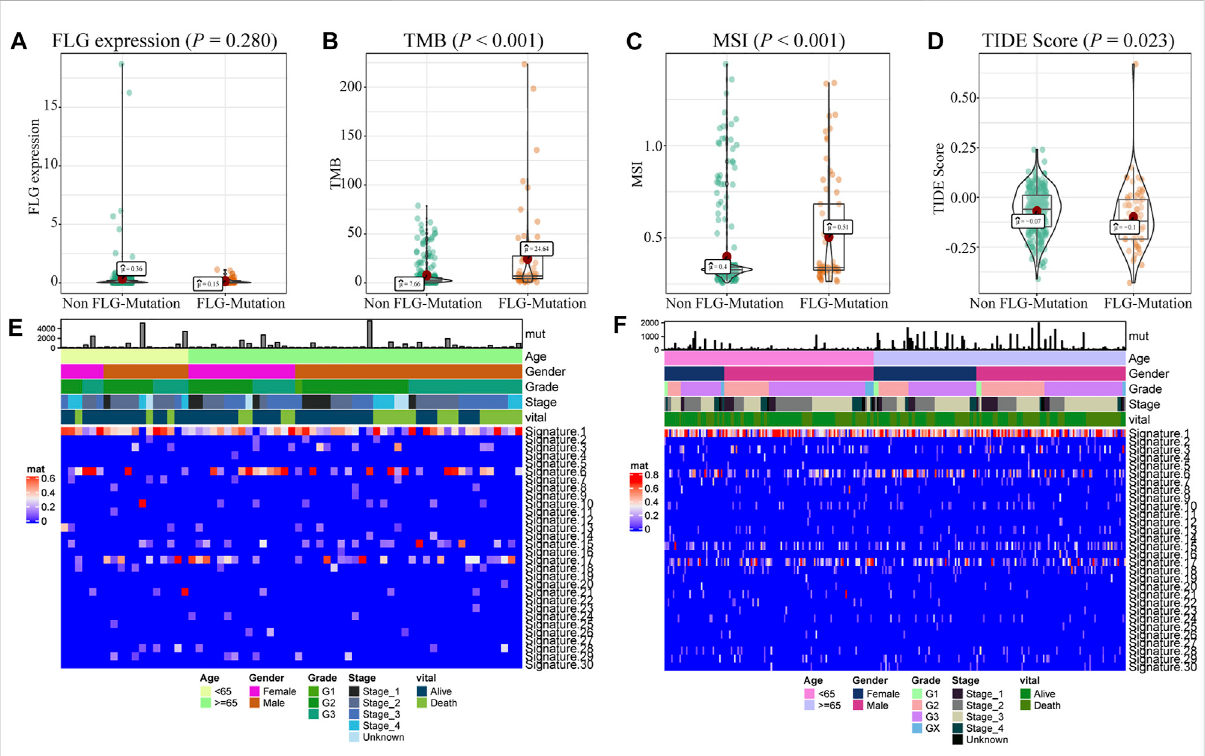
FIGURE 2 Biological characteristics of FLG gene mutations in STAD patients. (A) There were no signi fi cant differences in gene expression levels between patients with and without FLG mutations. ( p = 0.280). (B) TMB was signi fi cantly higher in patients with FLG mutation ( p < 0.001). (C) MSI was signi fi cantly higher in patients with FLG mutation ( p < 0.001). (D) Patients with FLG mutation had a signi fi cantly lower TIDE score than those in the non-mutantgroup( p =0.023).ThelowertheTIDEscore,thebettertheeffectofimmunotherapy. (E) Cosmicsignaturethermogramanalysisof FLG -mutant patients in the TCGA dataset, the corresponding clinical features of the patients are shown earlier. (F) Cosmic signature thermogram analysis of non-mutant patients in the TCGA